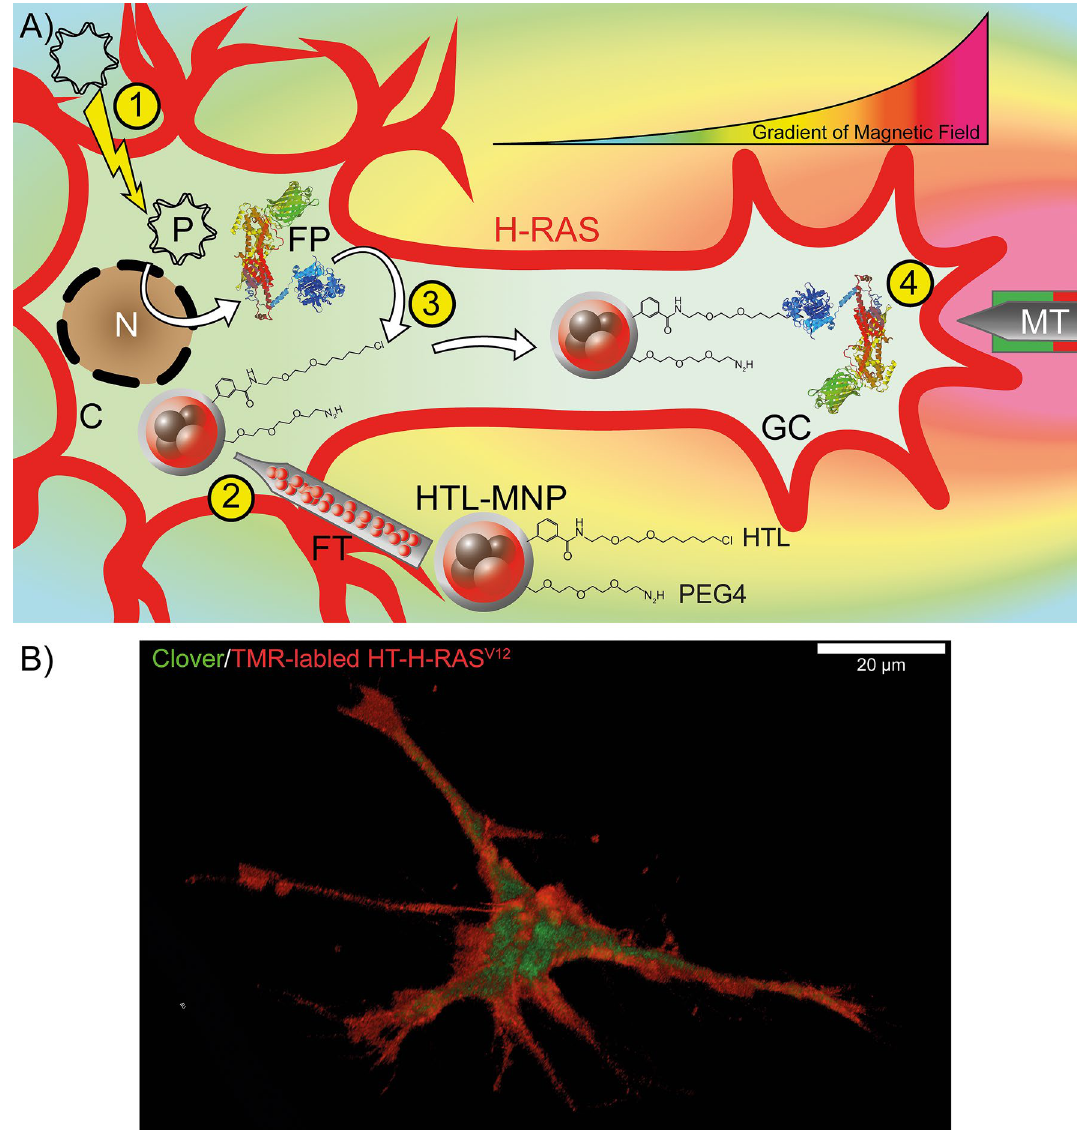
Figure 1. ( A ) Schematic outline of the experimental design. (1) The plasmid coding for HT-SOS1cat-Clover is electroporated, and the protein is expressed in the cell. (2) 48 h after the electroporation, magnetic nanoparticles functionalized with HaloTag Ligand (HTL-MNPs) are microinjected into the cell. (3) HT-SOS1cat-Clover is captured by the HTL-MNPs in the cytoplasm due to specific covalent binding of the HT to its ligand. (4) A magnetic tip is moved towards the neurite extension, which causes an accumulation of HT-SOS1cat-coupled MNPs in the growth cone in response to the applied magnetic field. Thus, HT-SOS1cat-Clover is translocated into the vicinity of the endogenous, membrane-anchored H-RAS, which cycles between its inactive GDP-bound and signaling active GTP-bound conformations. The magnetic field gradient is indicated by the curve above the growth cone (high magnetic field in red, low magnetic field in green; arbitrary units) and by the corresponding color gradient of the background. C cytoplasm, FP HT-SOS1cat-Clover fusion protein, FT Femtotip, GC growth cone, MT magnetic tip, N nucleus, P plasmid. Membrane-anchored H-RAS is indicated by the broad and thick red outline of the cell. ( B ) A three-dimensional confocal image of a PC12 cell transfected with HT-H- RAS V12 -IRES-Clover after in-cell binding of the red-fluorescent cell-permeable dye TMR-HTL 2 days after the transfection. Note that morphological differentiation was achieved in the absence of NGF due to the neurite promoting activity of H-RAS V12 after the transfection (see Fig. 3). Three-dimensional reconstruction was performed using images from 55 Z-layers that cover a total distance of 18.9 µm. The scale bar represents 20